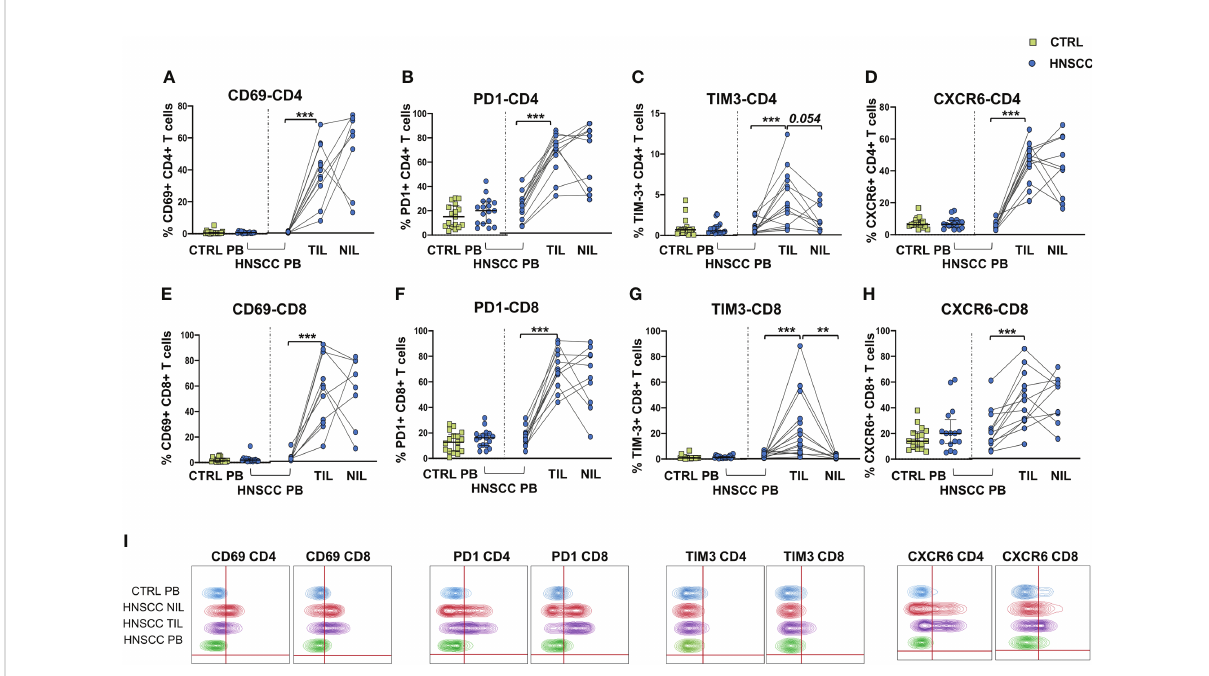
FIGURE 8 Proportions of (A) CD69, (B) PD-1-, (C) TIM-3-, and (D) CXCR6- positive CD4 T cells in PBMC from control subjects (CTRL PB), from HNSCC patients (HNSCC-PB) as well as matched tumor-in fi ltrating (TIL) and non-tumor-in fi ltrating lymphocytes (NIL). Frequencies of CD8 T cells expressing (E) CD69, (F) PD-1-, (G) TIM-3-, and (H) CXCR6. The Mann – Whitney U test was used to compare CTRL and HNSCC subjects. Paired data were analyzed by the Wilcoxon signed rank test. **p < 0.01, ***p < 0.001. (I) Representative concatenated fl ow cytometry plots showing the percentage of CD4+ and CD8+ T cells expressing the indicated phenotypic